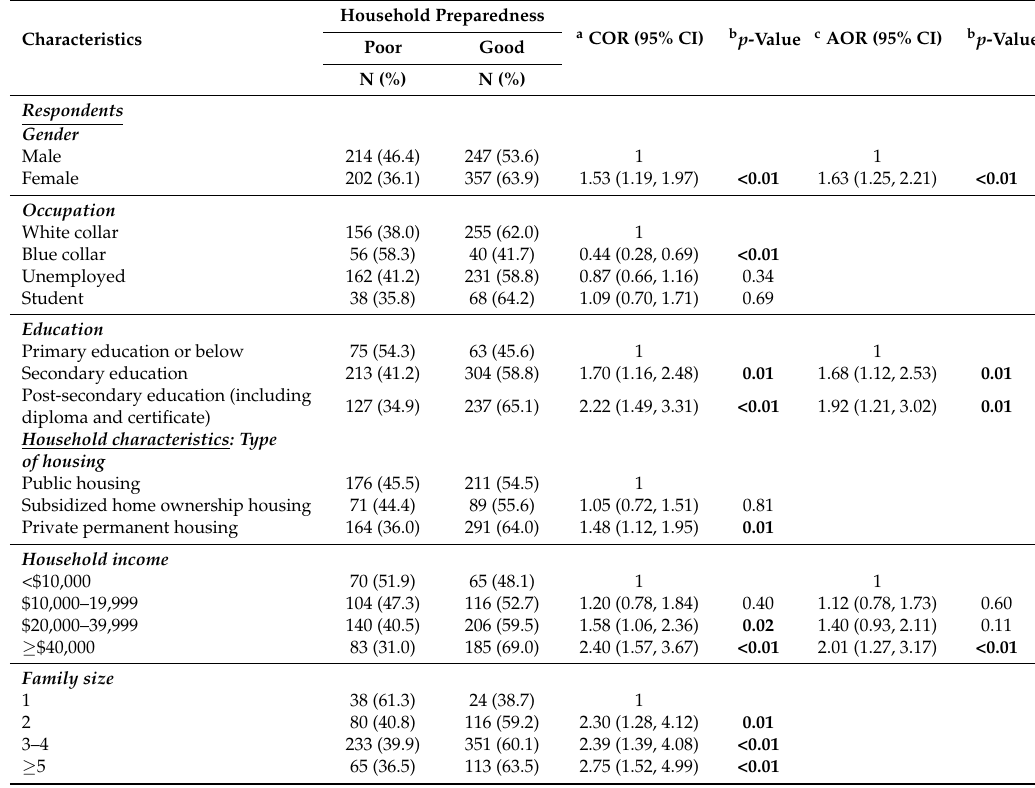
Table 2. Socio-demographic characteristics of respondents associated with good household preparedness.